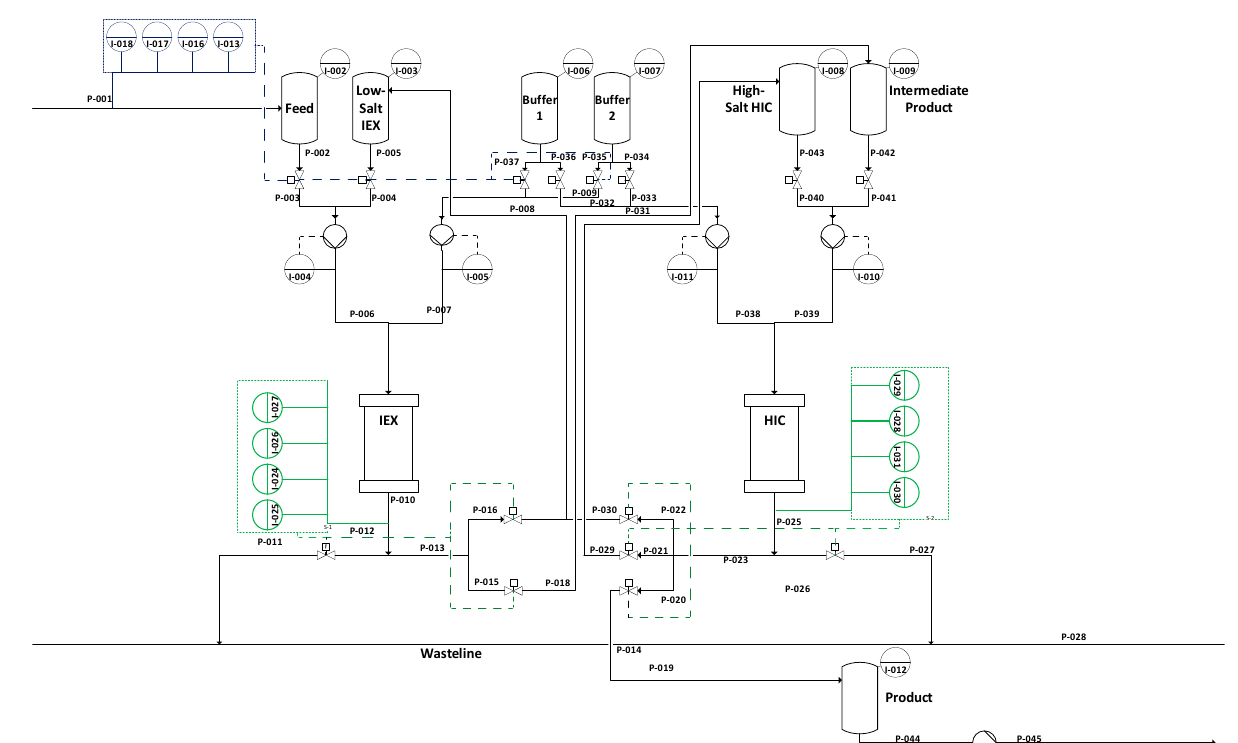
Figure 18. Proposed control strategy for iCCC.